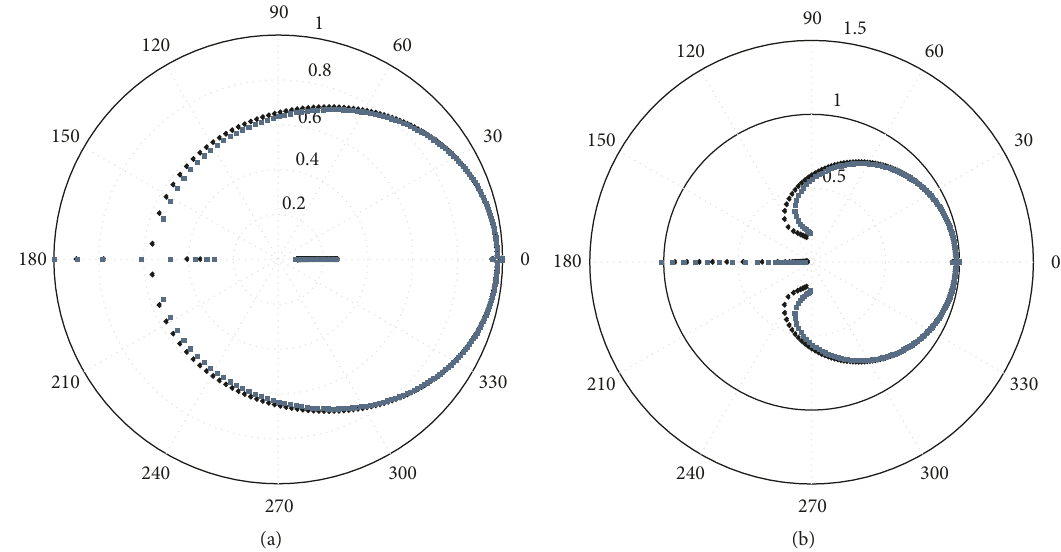
Figure 3: Root locus of the stability polynomial in the Z-domain for Figure 1. Legends: Black circle: Newmark-FDTD/ADE-FDTD with BT; blue-gray square: